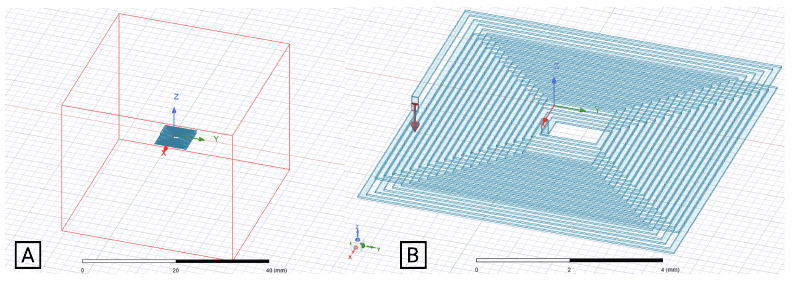
Figure 8. ( A ): Ansys project with 2-layer coil and air box. ( B ): Current applied into the